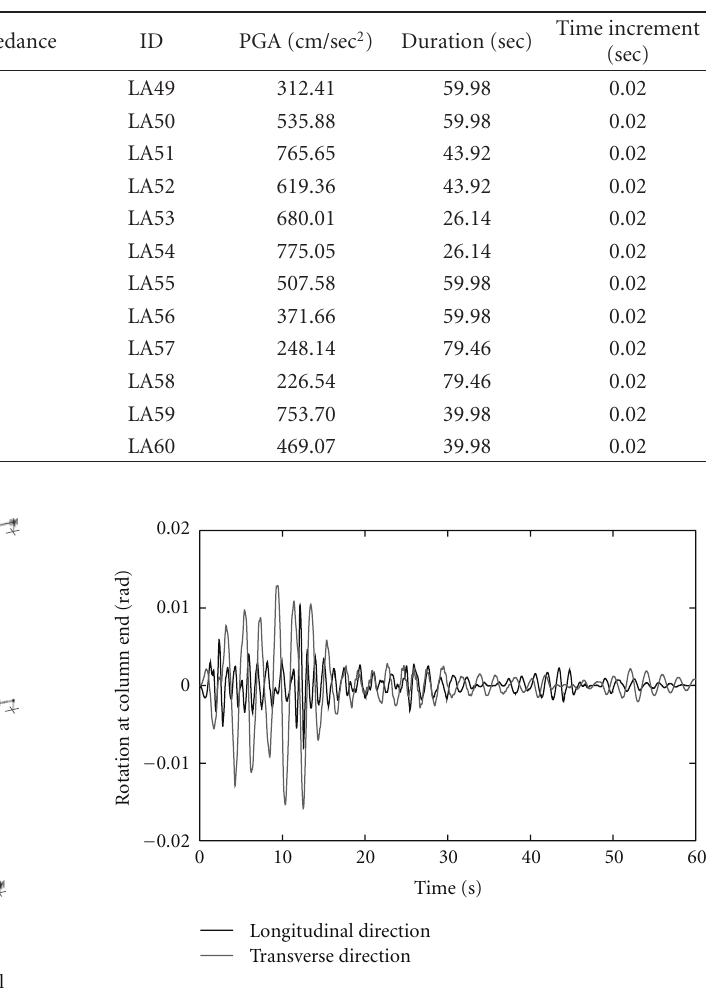
Figure 8: Rotation of pier end under one typical ground